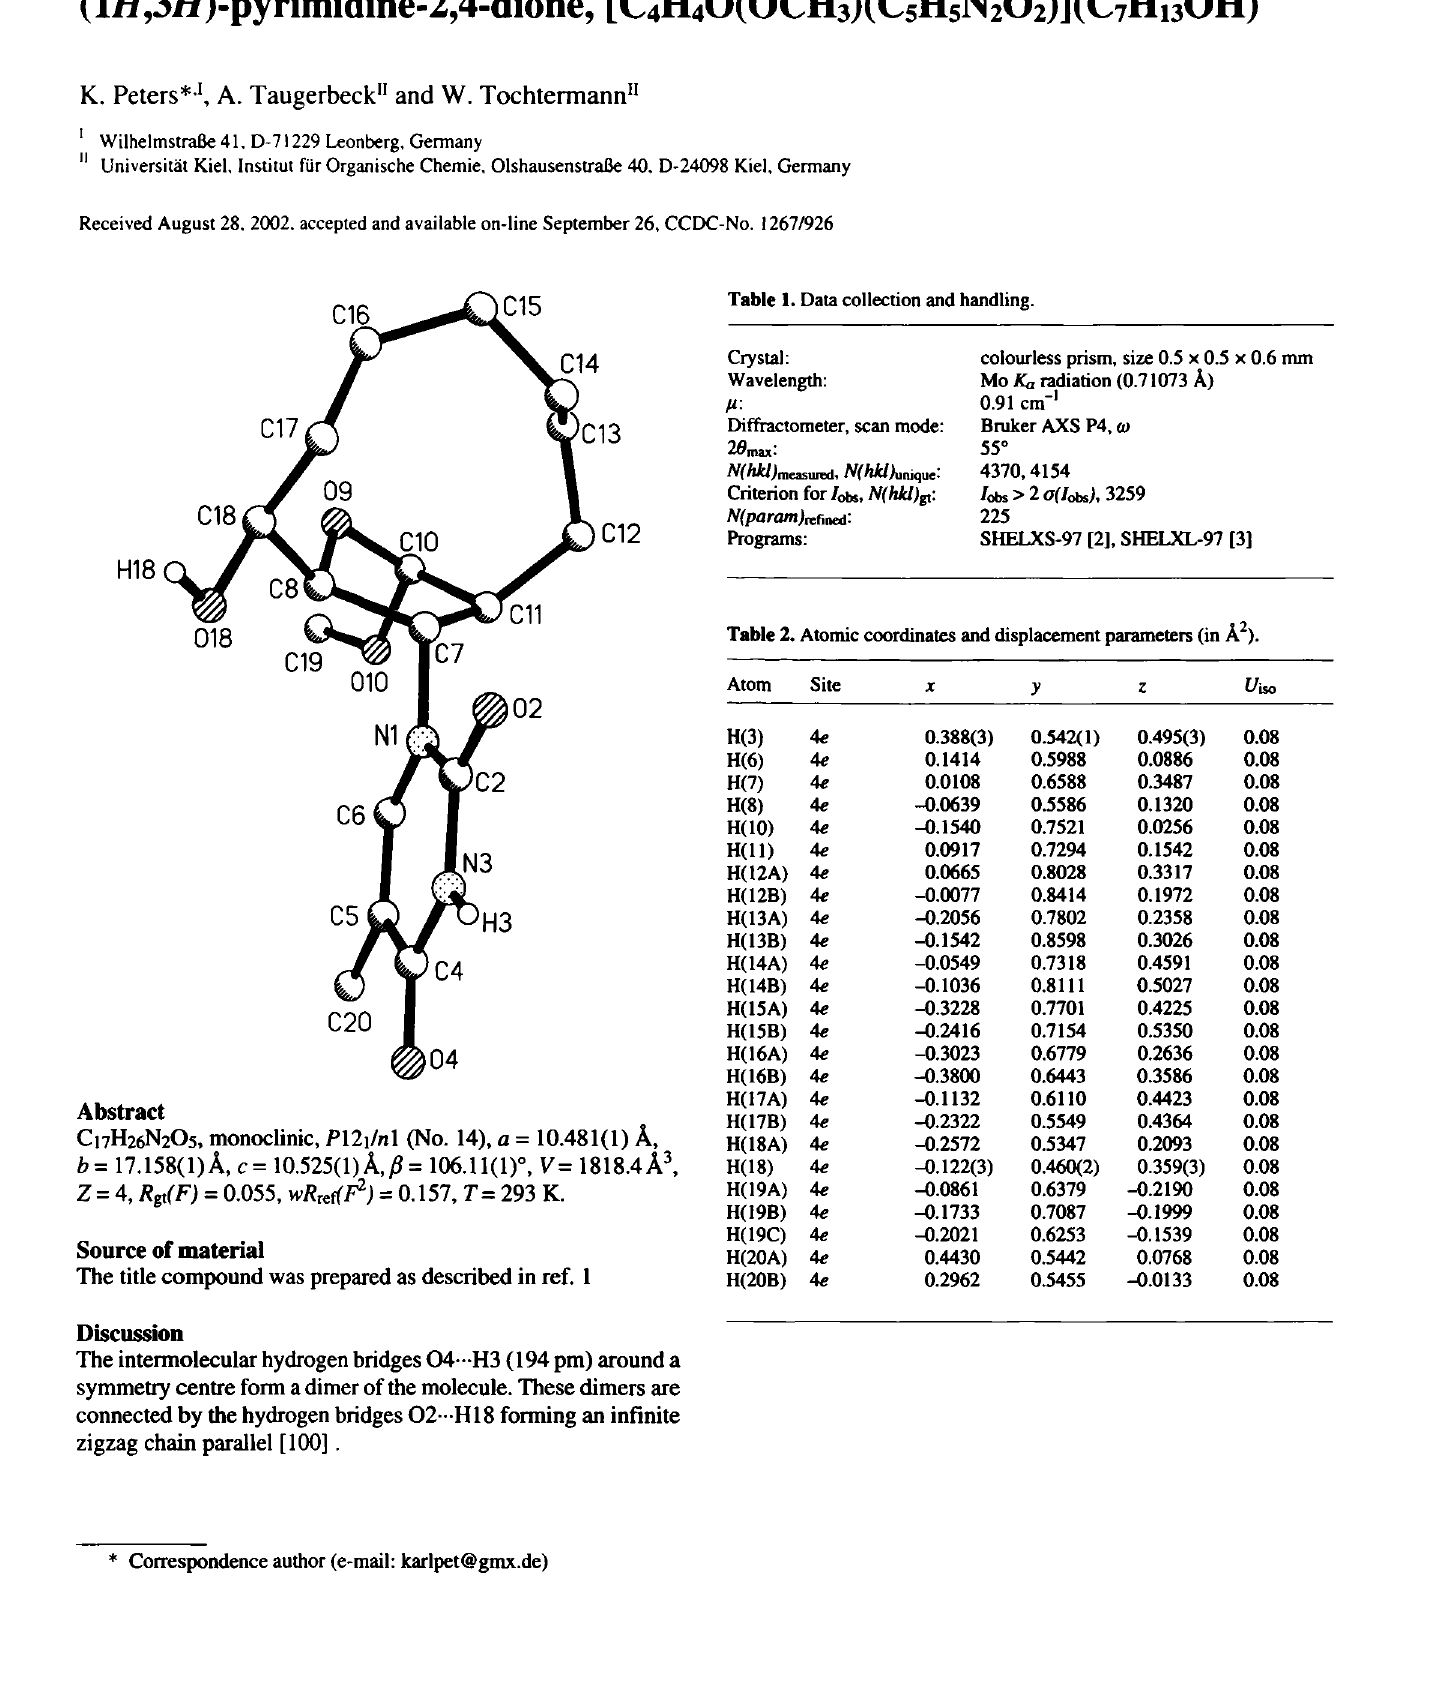
Table 1. Data collection and handling.